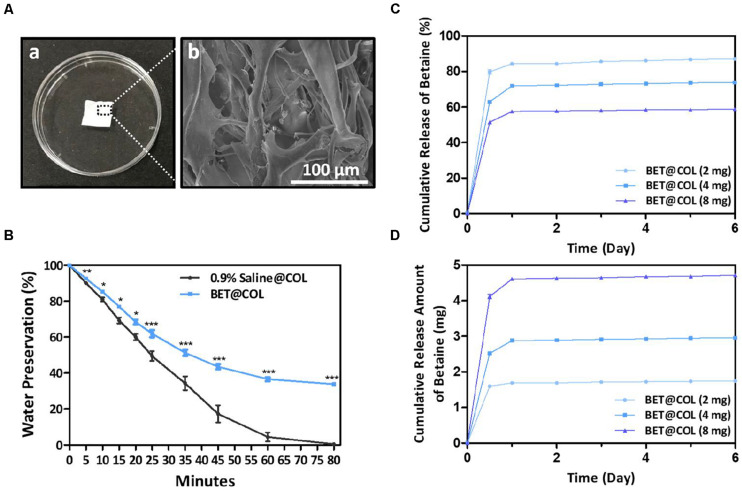
Characteristics and betaine release of BET@COL. (A) Photographs of thin collagen sponge dressing and its inner instruction (a) of collagen sponge dressings by SEM (b). Scale bar: 100 μm. (B) Water preservation percentage of BET@COL, n = 3. (C,D)
In vitro release profile of BET@COL. The cumulative release percentage (C) and the cumulative release amount (D) of betaine of different drug load (2 mg, 4 mg, and 8 mg) measured by HPLC, n = 3. BET, betaine; COL, collagen. Statistical differences were performed using ANOVA. ***p < 0.001, **p < 0.01, *p < 0.05.